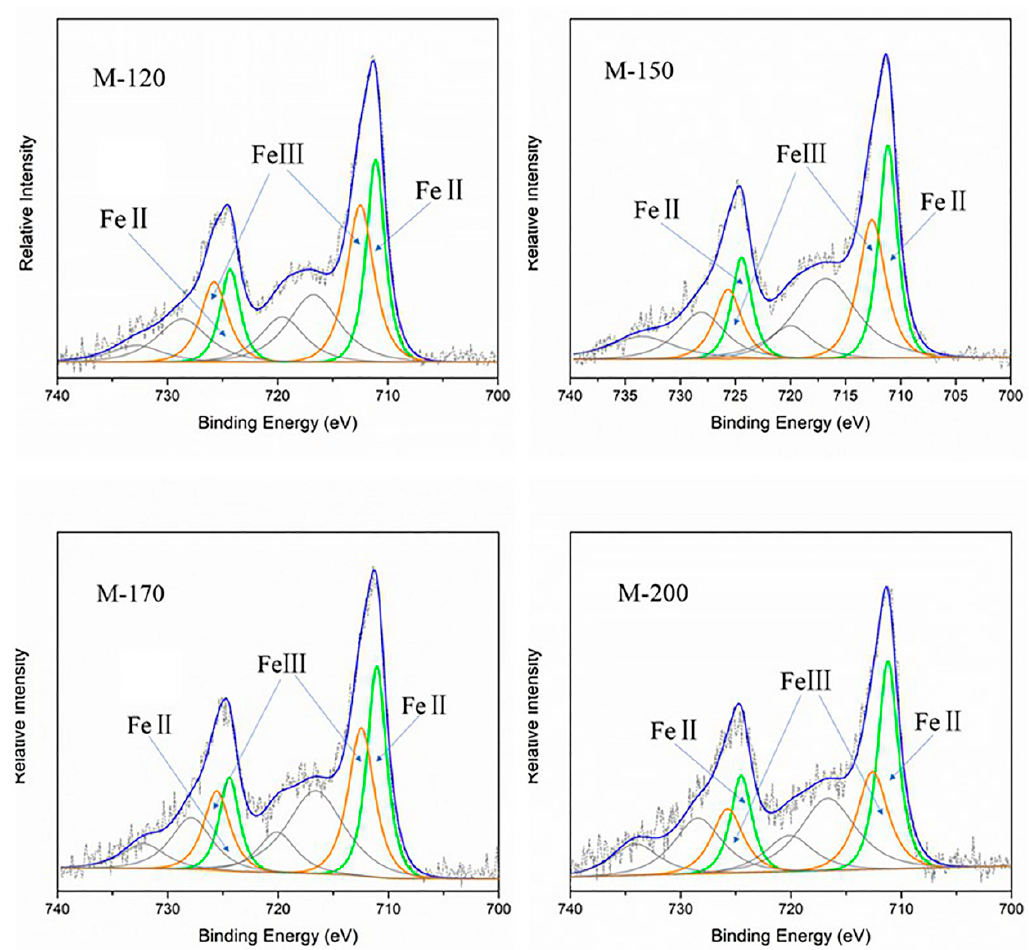
Figure 7. Fe2p high-resolution spectra of activated samples.